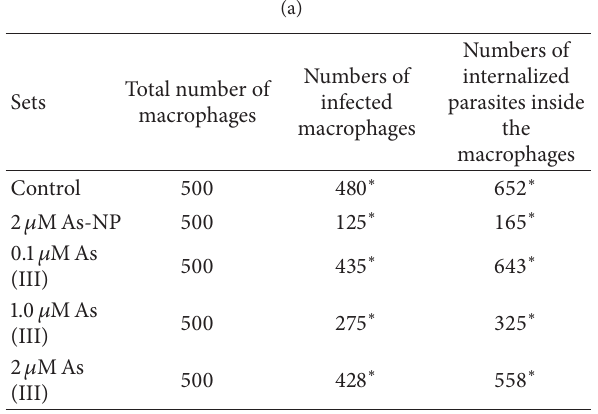
Table 1: 𝑃 values for each data point in Figures 2(a) and 2(b). Table 2: (a) Inhibition of parasite infection (at 37 ∘ C for 24 hours). (b) Inhibition of parasite attachment (at 4 ∘ C for 4 hours).